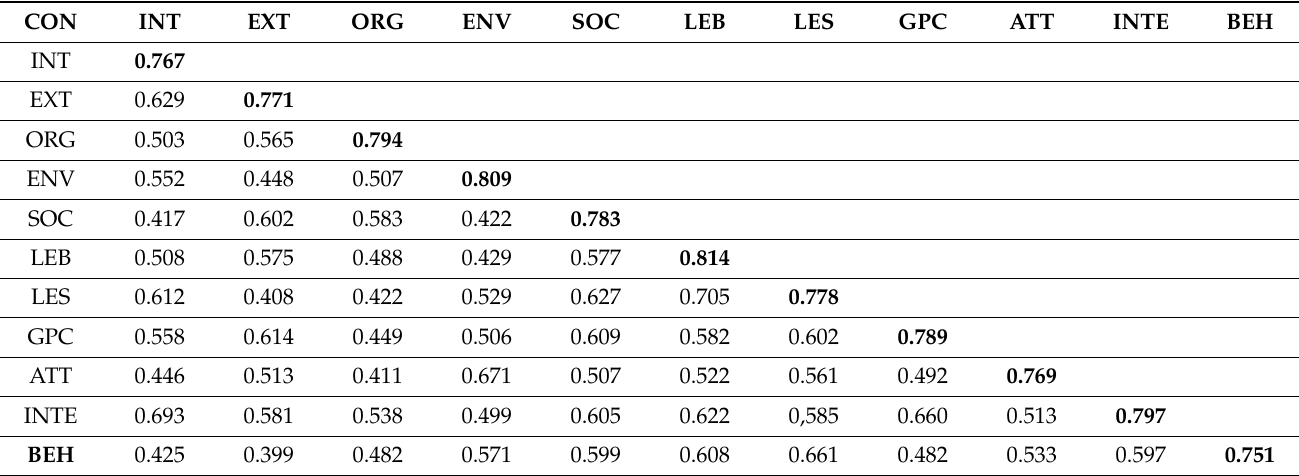
Table 2. Discriminant